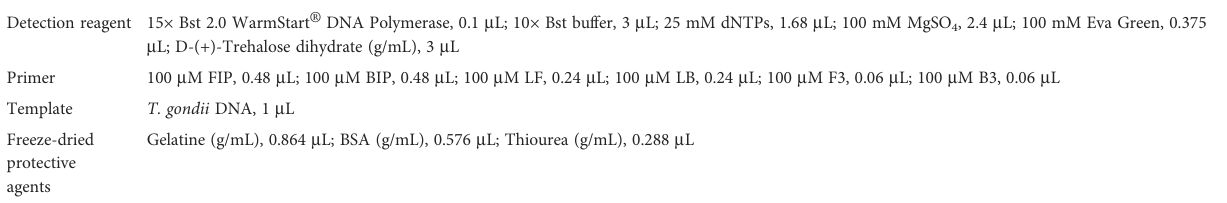
The reactions (30 m L)